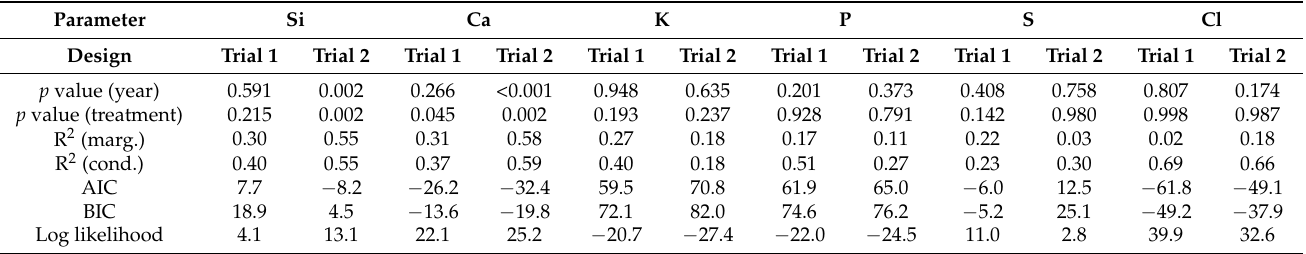
Sr. The mixed model ANOVA test results and the performance data for the model for macro-elements in oat grains are presented in Table 2 and for microelements in Table 3. In both trials, differences between treatments were observed for Ca ( p = 0.045 and p = 0.002, respectively) and Zn ( p = 0.011 and p = 0.010, respectively). Differences in the levels of Si were observed only in Trial 2 ( p = 0.002), and Fe ( p = 0.044) and Ti ( p = 0.010) only in Trial 1 and Trial 2, respectively. Significant differences between sampling years were observed for the macroelements Si ( p = 0.002, Trial 2) and Ca ( p < 0.001, Trial 2) and microelements Fe ( p = 0.027 and p < 0.001, Trial 1 and Trial 2, respectively), Rb ( p = 0.042 and p < 0.011, Trial 1 and Trial 2, respectively) and Sr ( p = 0.009 and p < 0.008, Trial 1 and Trial 2, respectively). Table 2. Summary data of the linear mixed model ANOVA for macroelements in oat grains produced during 2016–2017.